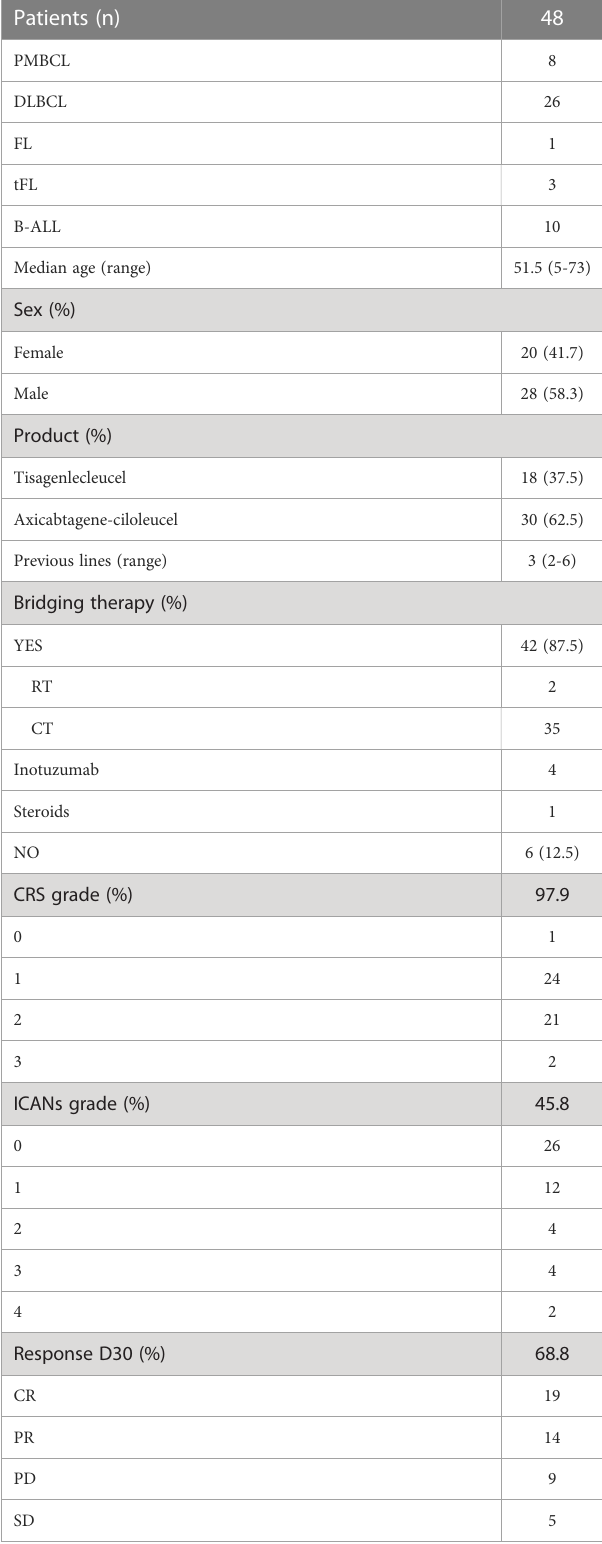
TABLE 1 Characteristics of the patients included in the